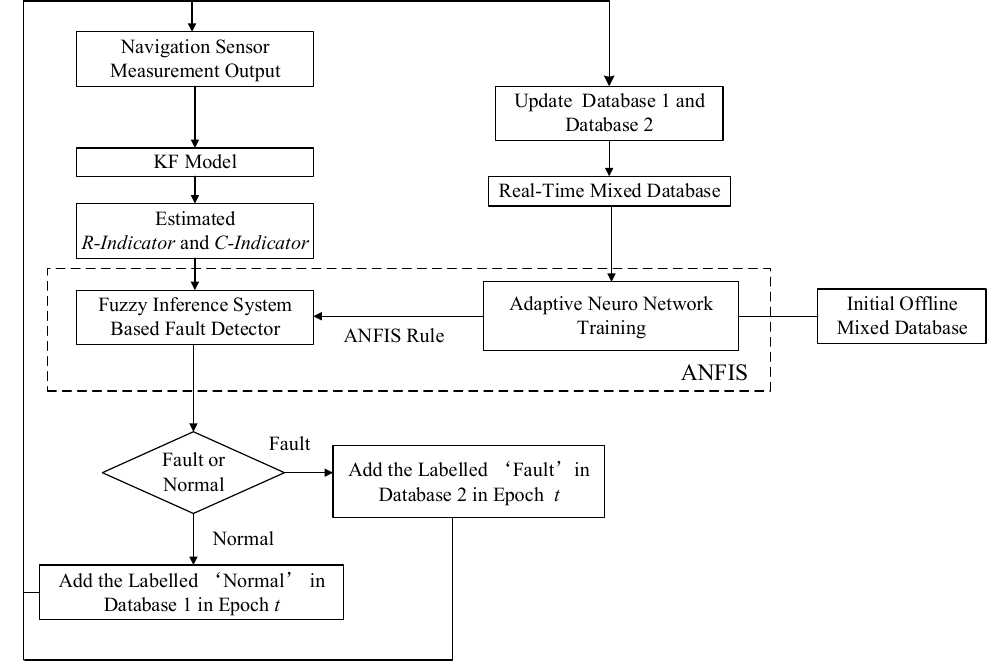
Figure 1. Overview of the algorithm. ANFIS, Adaptive Neuron Fuzzy Inference System; KF, Kalman Filter.